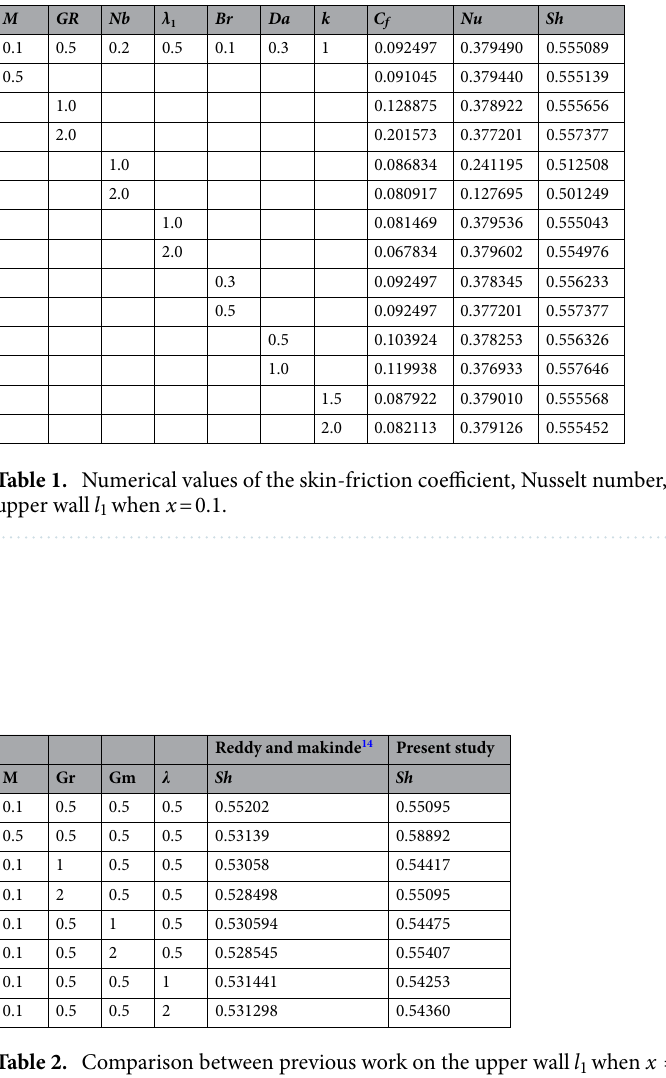
Table 2. Comparison between previous work on the upper wall l 1 when x =